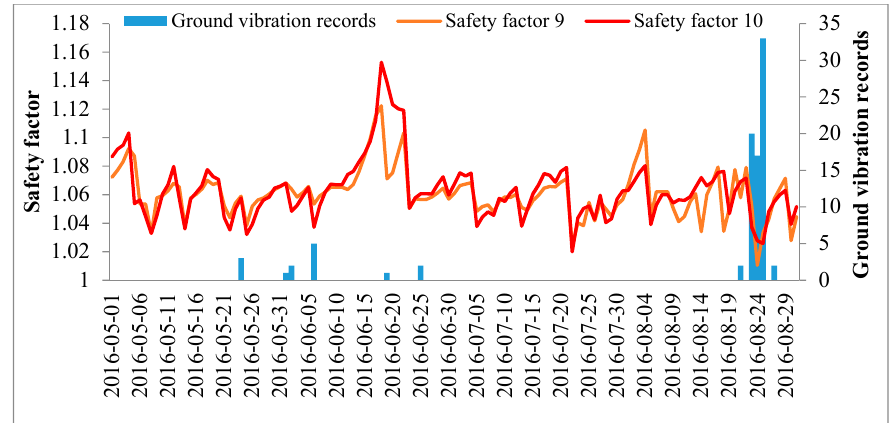
Figure 9. Ground vibration records and modeled factor of safety changes in the Yindongzi landslide site from 1 May to 30 August 2016.